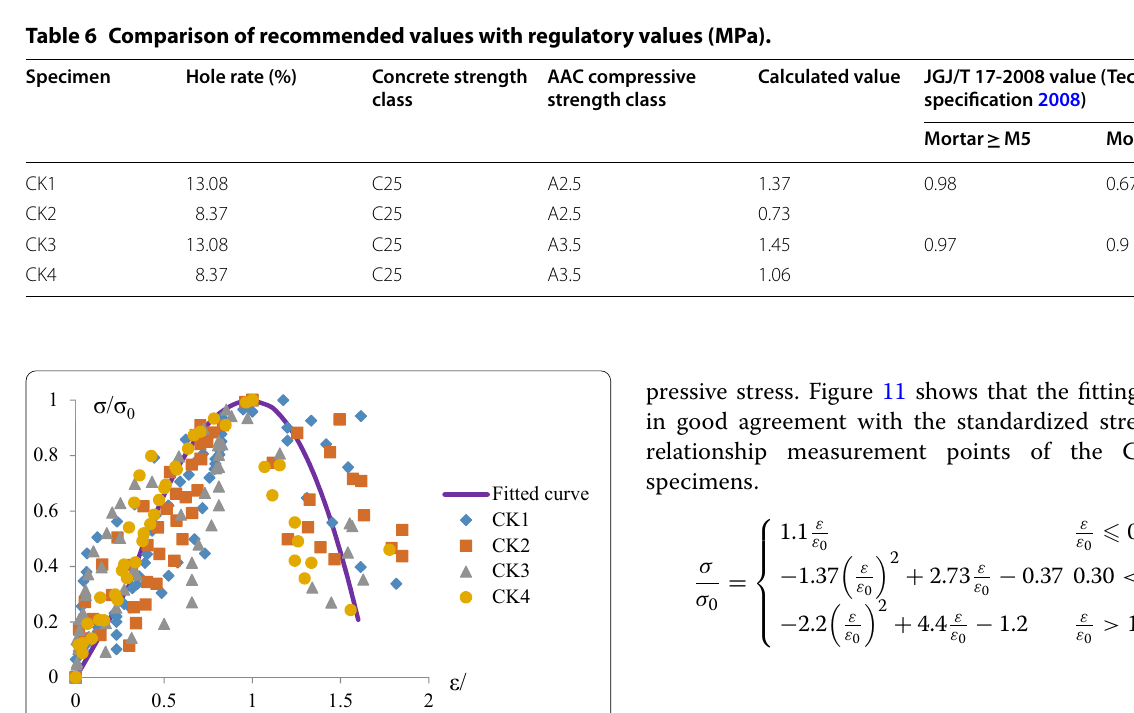
a f 0 g . m is the average value of the measured compressive strength of the masonry. b f g . m is the average value of the calculated compressive strength of the masonry.